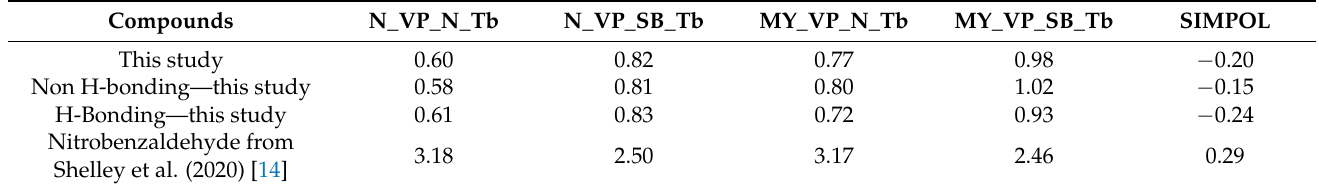
Table 6. Mean order of magnitude difference between the experimental and predicted P sat method [6]. MY_VP is the Mydral and Yalkowsky method [7] N_Tb is the Nannoolal et al. method [36]. SB_Tb is the Stein and Brown method